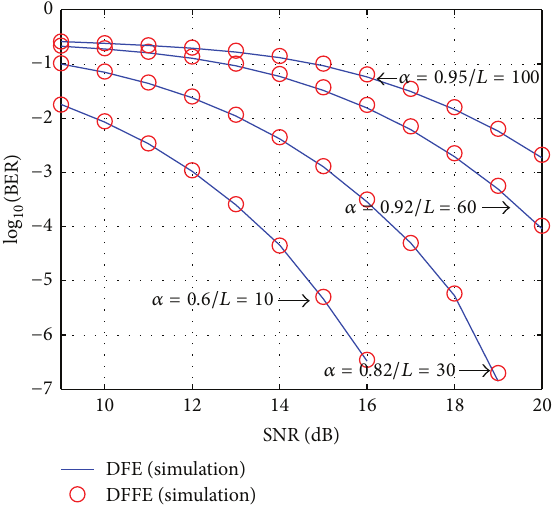
Figure 5: Performance of DFE and adaptive DFFE with 𝑅 = 𝐿 + 1 for different postcursor ISI